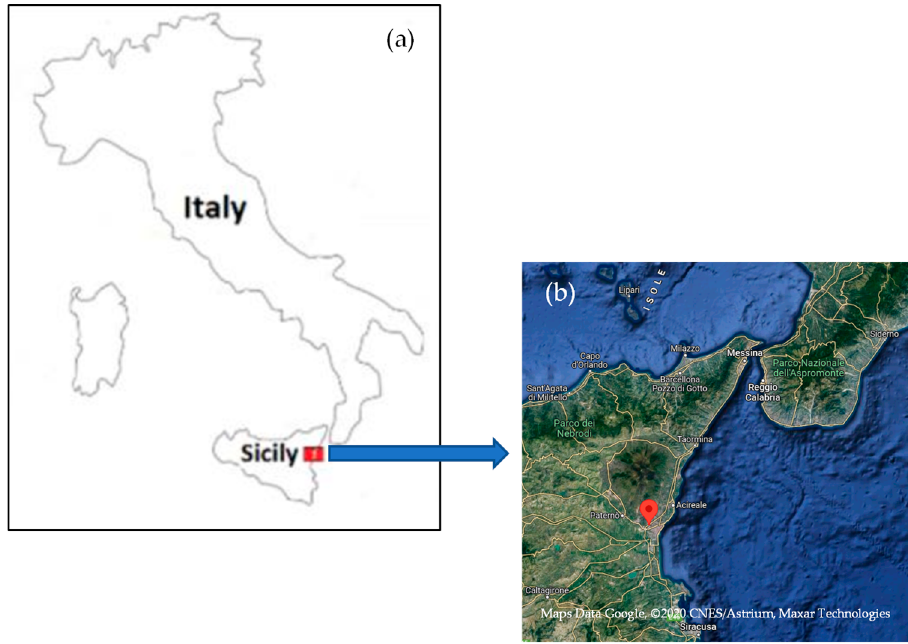
Figure 1. The sampling area ( a ), with the specimen location indicated ( b ).